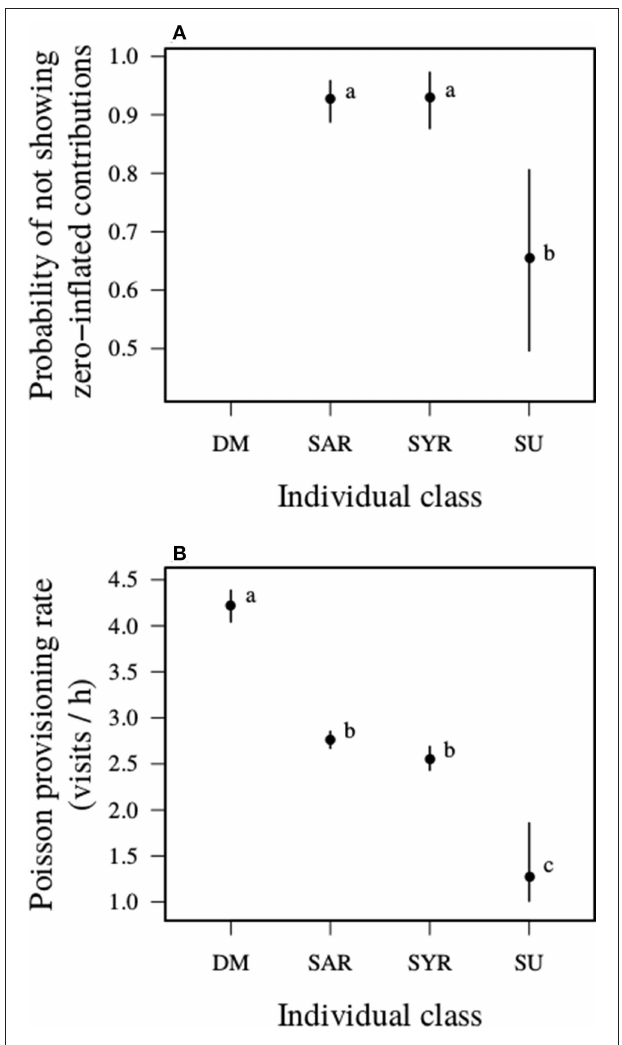
FIGURE 2 | Daily provisioning rates of different classes of carers. Carer classes varied in: (A) their propensity for zero-inflation (i.e., visiting the nest less often on a given day than expected by a Poisson distribution); and (B) their provisioning rate based on a Poisson expectation. DM, dominant breeding males; SAR, helping adult relatives of at least one member of the breeding pair; SYR, helping yearling relatives; SU, unrelated helpers that were more distantly related or unrelated to either member of the breeding pair. The different letters inset indicate where the 95% CI of the difference between the categories did not include zero. Plots show marginalized prediction of means and 95%